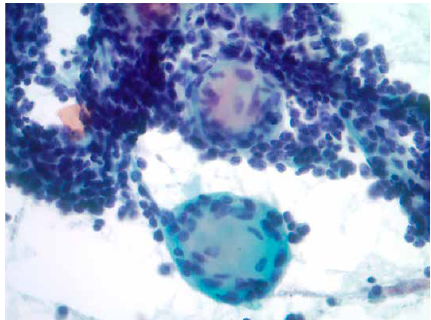
Figure 4: Large, cohesive, three-dimensional aggregates of cellular material predominate in the direct smears. These show spheroidal globules of eosinophilic to amphophilic extracellular material with intimately associated small to intermediate sized spindled and epithelioid cells. While appliqueed spindled cells are noted on the spheroids, true intrinsic fibrovascular cores are not identified (Papanicolaou stain, 200X).